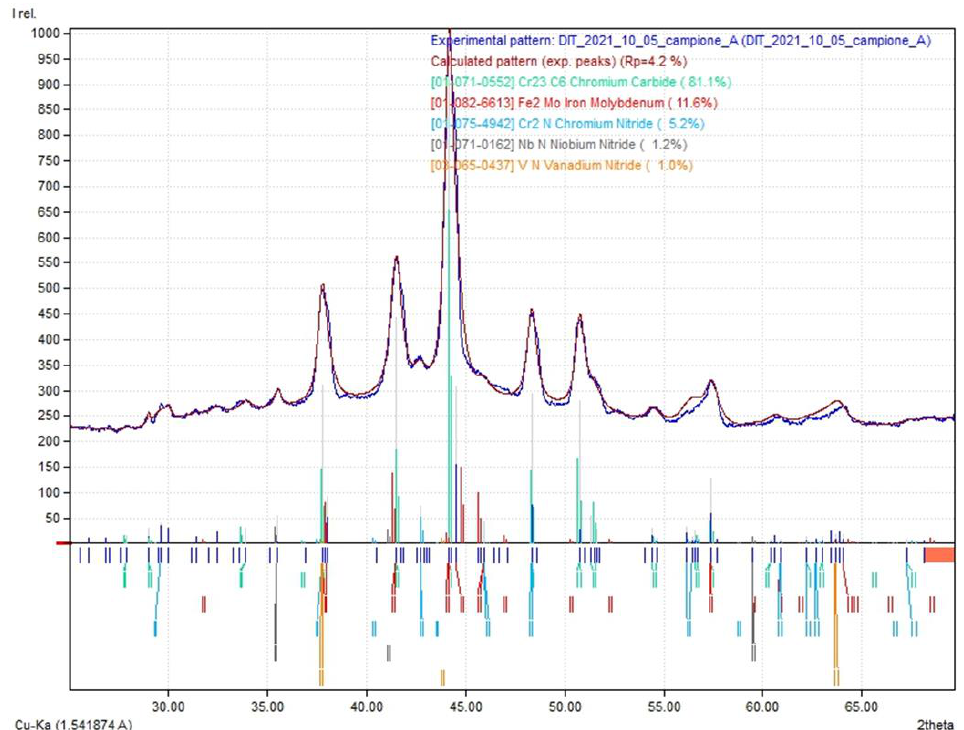
Figure 4. Subproject N°3: GR 91 HAZ CREEP, failed crept cross-weld specimen 91-HAZ-3-1 550 °C 200 MPa 4395 h (sample A).